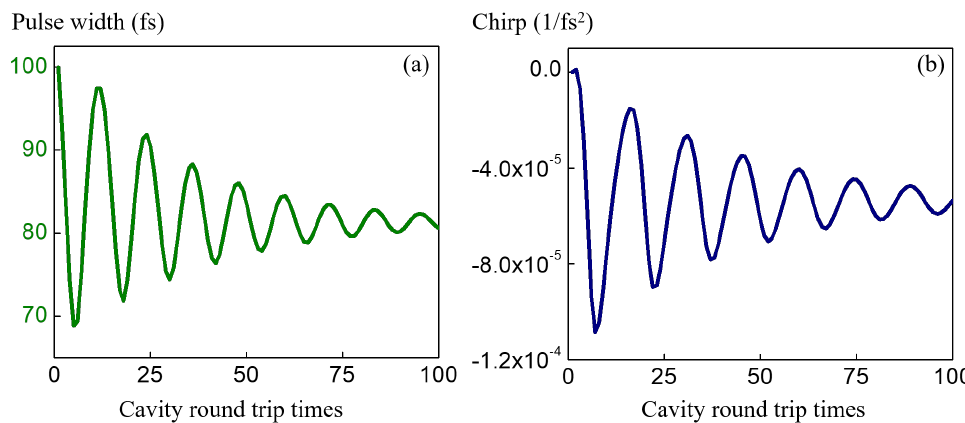
Figure 4. ABCD time transfer matrix method is applied to simulate single pulse (Ti:Sapphire cavity alone) circulating in the cavity. The convergence of the ( a ) pulse width and the ( b ) chirp coefficient are showing the compensation of the self phase modulation and dispersion in a stable time cavity.